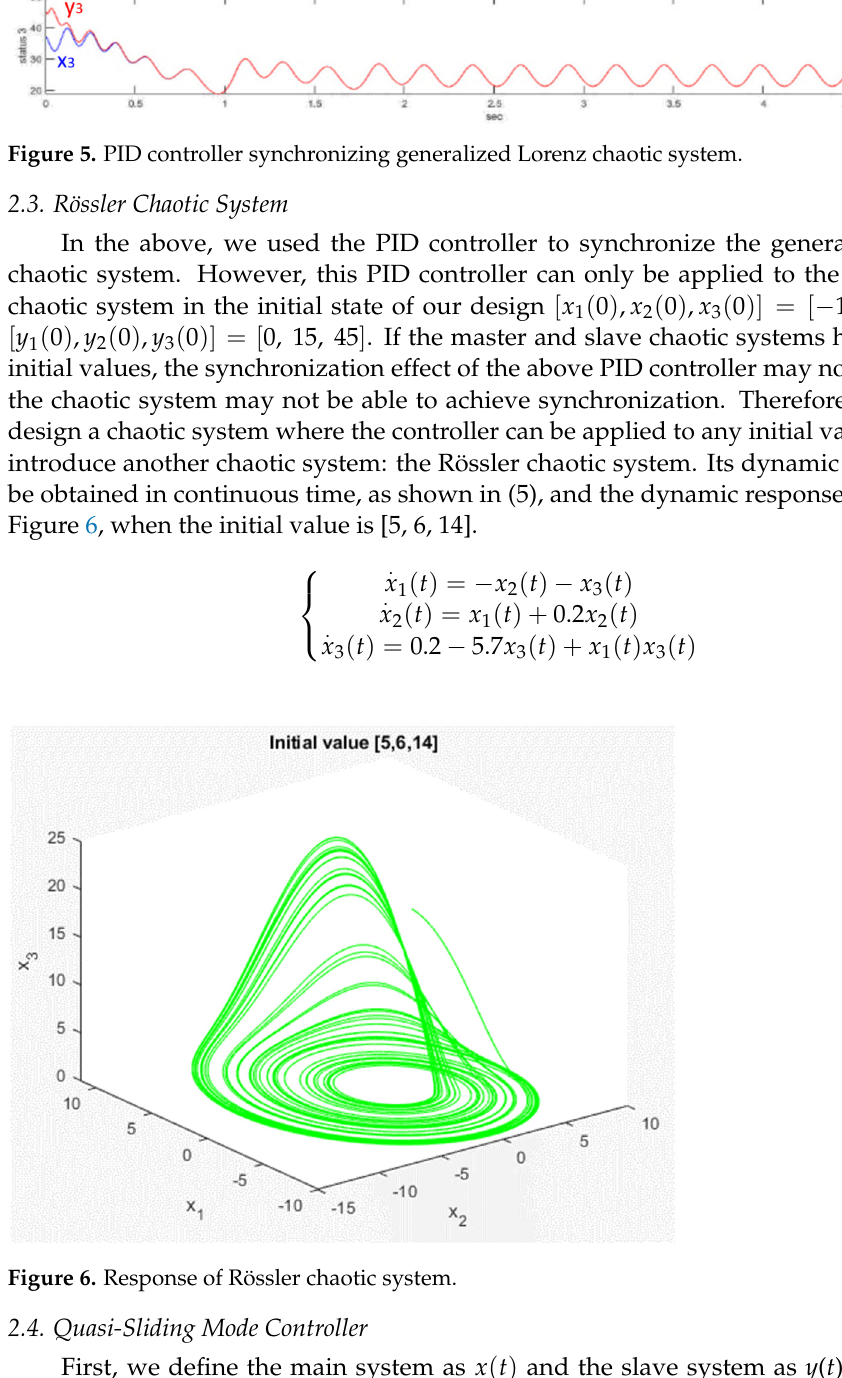
Figure 5. PID controller synchronizing generalized Lorenz chaotic system.